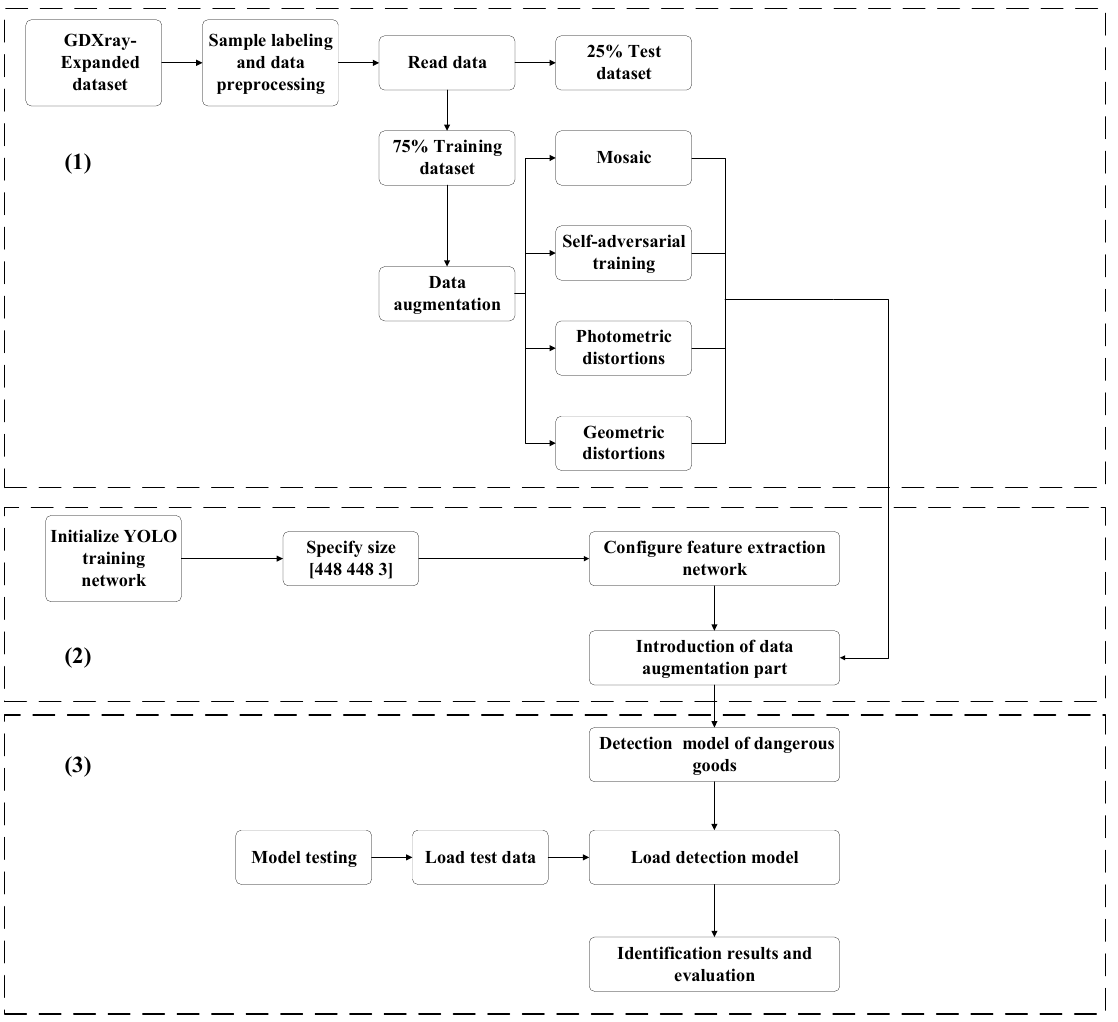
Figure 10. Experimental methodology: (1) dataset preprocessing and data enhancement; (2) training the YOLO network; (3) testing the trained model.